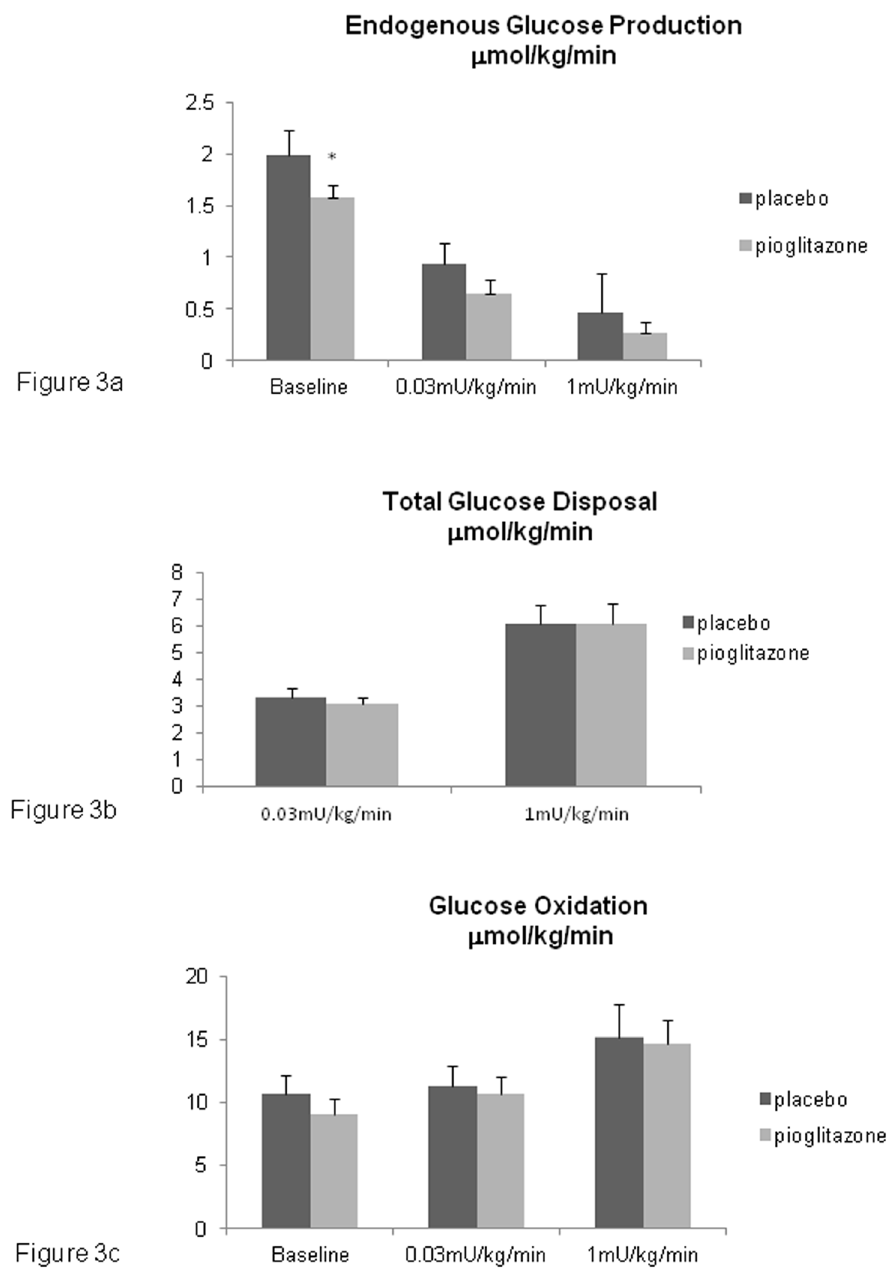
Figure 3. Glucose metabolism during a 2-step HEGC, values at baseline and during insulin infusion rates of 0.03 mU/kg/min and 1 mU/kg/min. * p , 0.05.